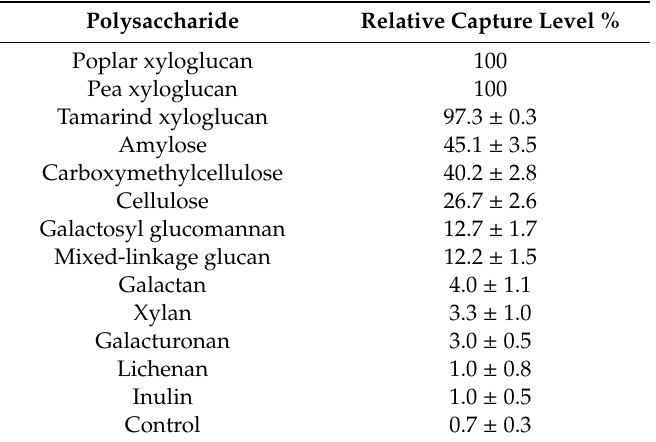
Table 2. Proportions of captured radioiodine gas.